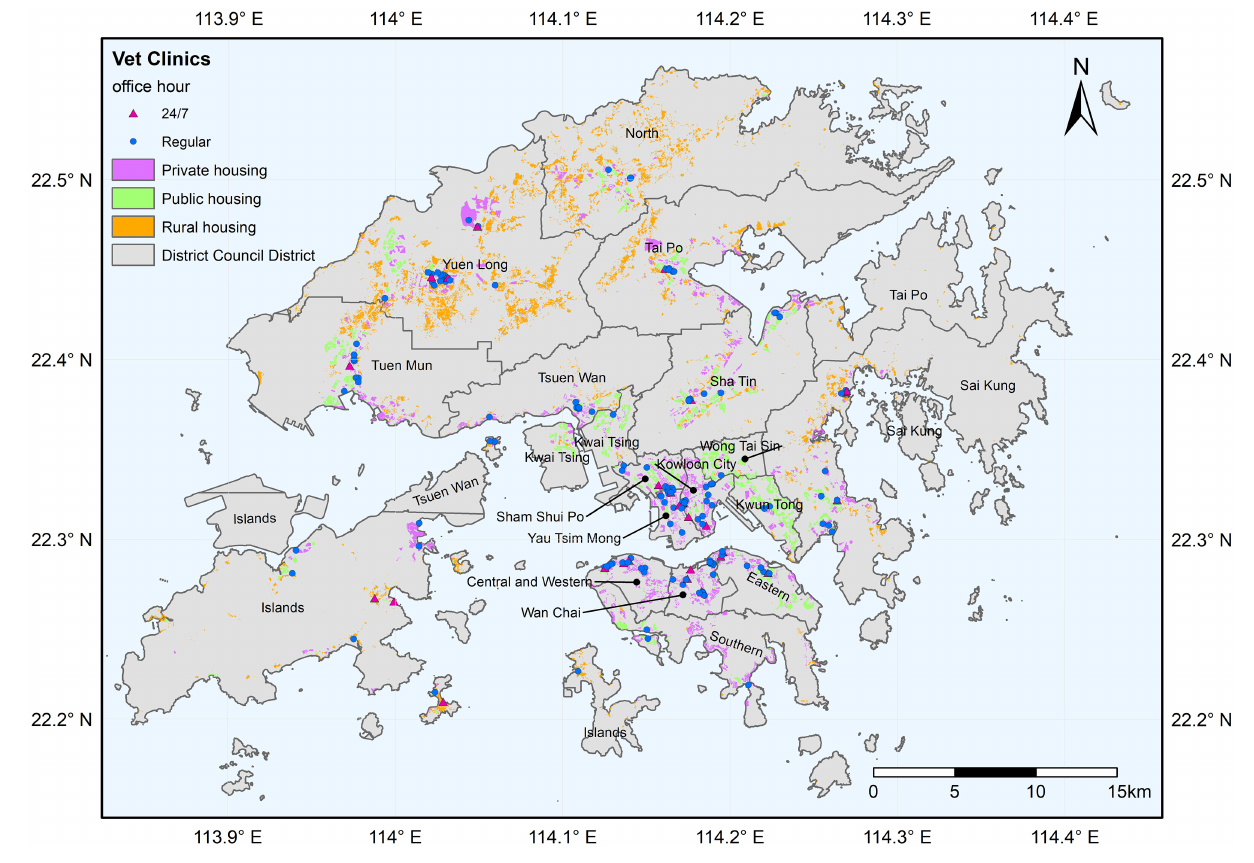
FIGURE 1 | Spatial distribution of general and 24/7 vet clinics and the residential types in Hong